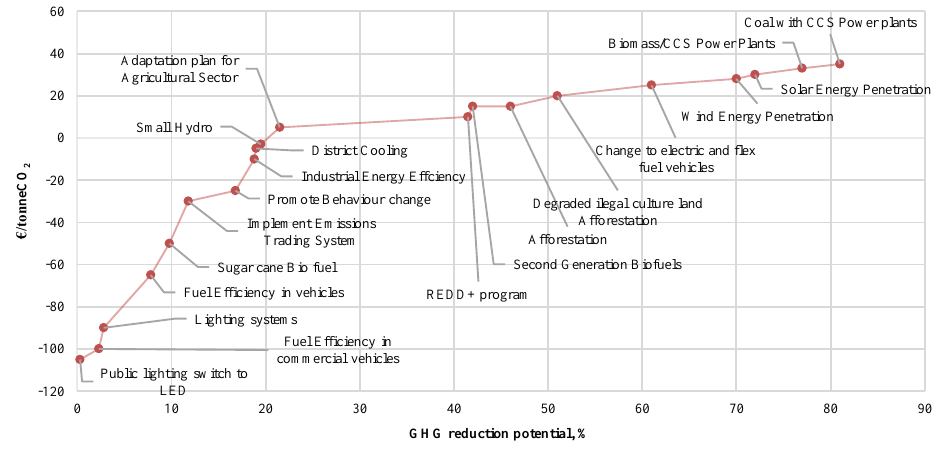
Fig. 4. MAC curve for technology diffusion in Colombia.